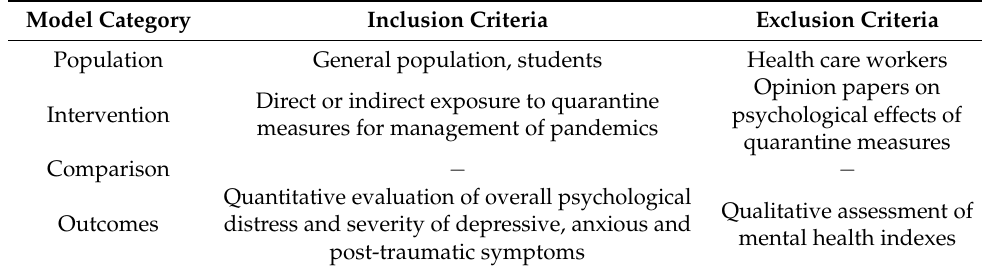
Table 1. PICO model for inclusion and exclusion